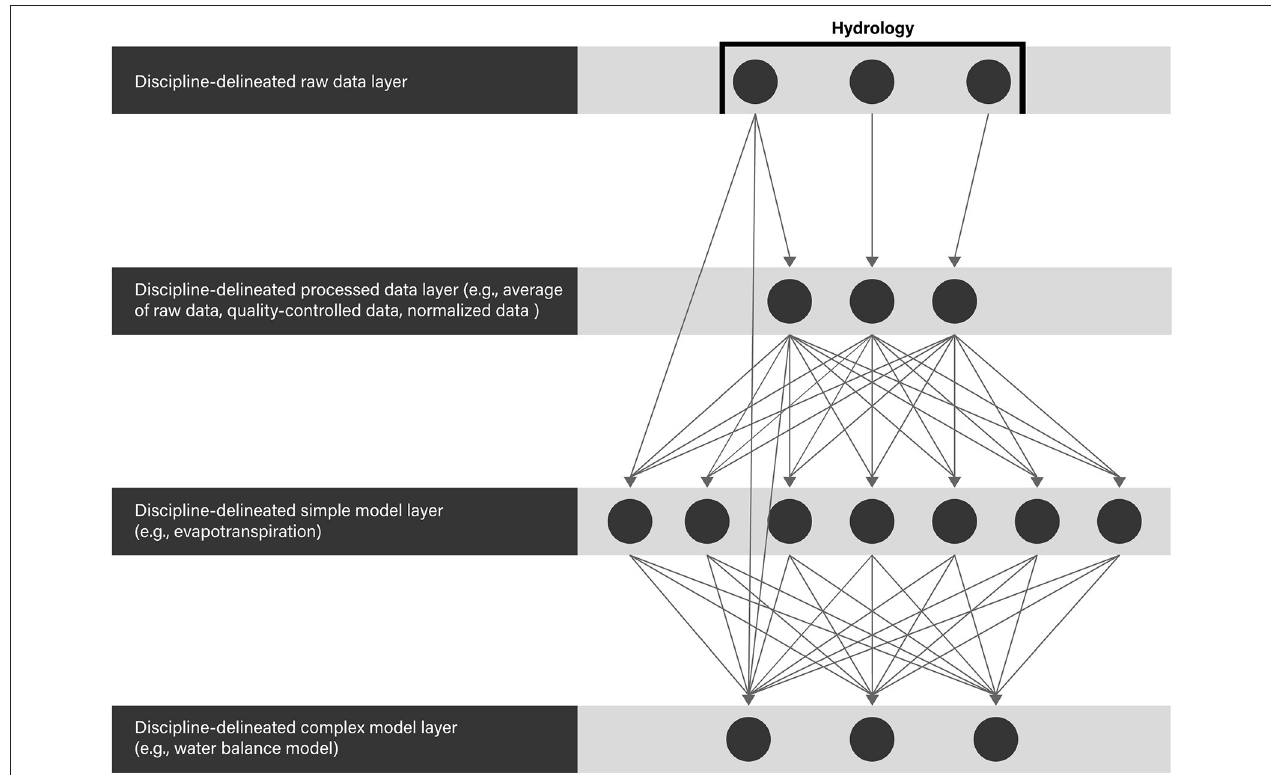
FIGURE 3 | Architecture of the envisioned knowledge workflow management of agricultural